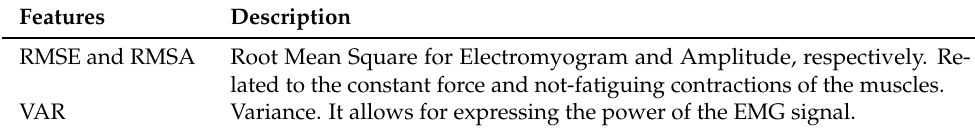
Table 2. Description of the extracted EMG